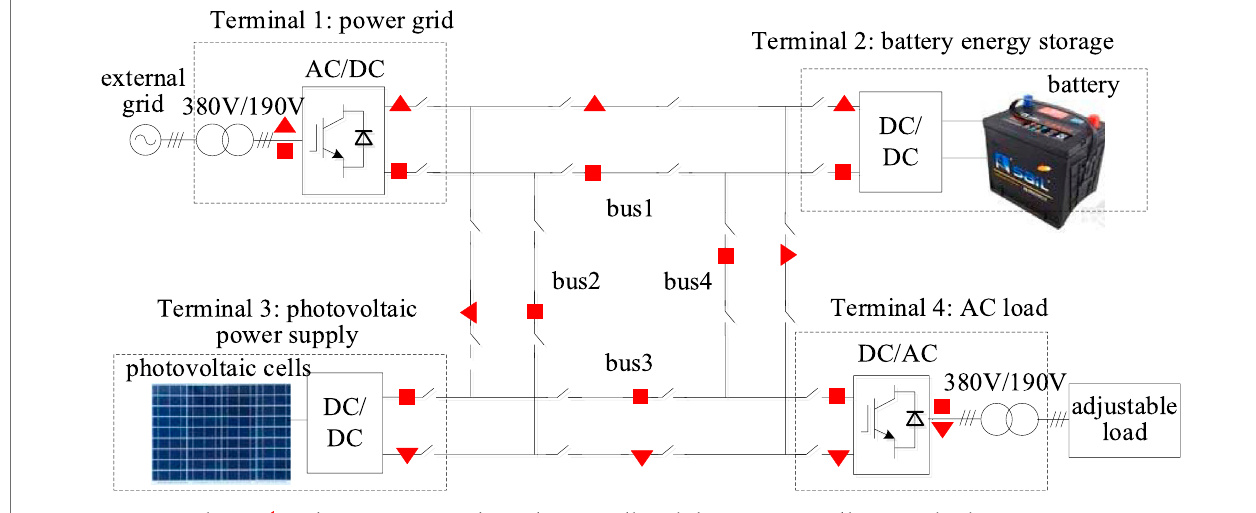
FIGURE 7 | Topology of the DC microgrid prototype.